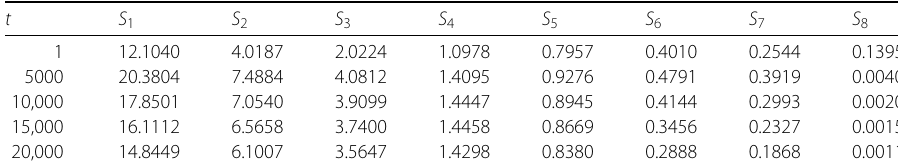
Figure 11 Approximated salinity of simulation 3 at station S 1 by (cid:4) x = 0.1 and (cid:4) t = 0.05 for all 0 ≤ t ≤ 1000